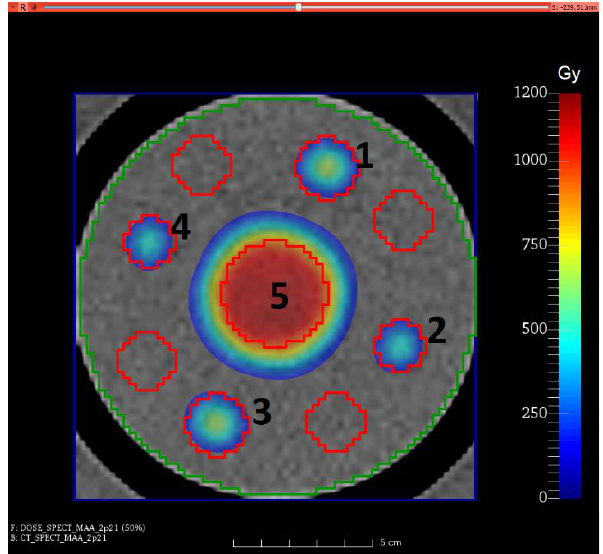
Figure 2. Phantom ROI on a similar slice of CT and SPECT-MAA-based ADD. Cubic voxels of 2.21 mm length were used after resampling both images. The red circles represent the ptv_5_cyl_backg mask (i.e., including four samples of the background near the PTV) or the ptv_5_cyl mask (i.e., excluding the four background samples). The individual PTV cylinder masks (red circles) are numbered 1 through 5. The liver_box and the liver_cyl masks are represented by the blue square and the green circle, respectively.